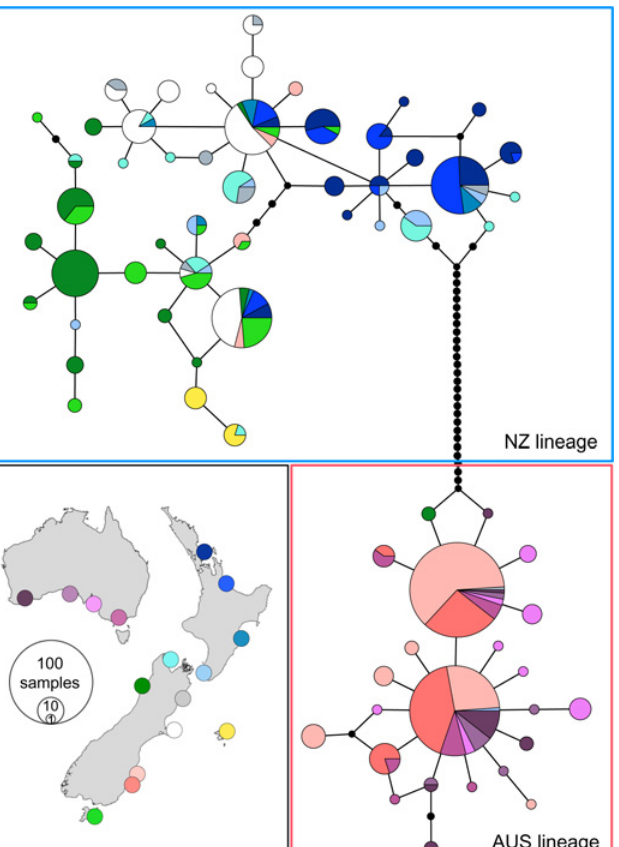
Fig 3. Median-joining network of Eudyptula mitochondrial control region haplotypes. Circle size is proportional to haplotype frequency. Colours represent different sampling locations as indicated on the map. Edges between haplotypes represent single mutational steps. Unobserved haplotypes are indicated by small black circles. The red and blue boxes indicate AUS and NZ lineages,